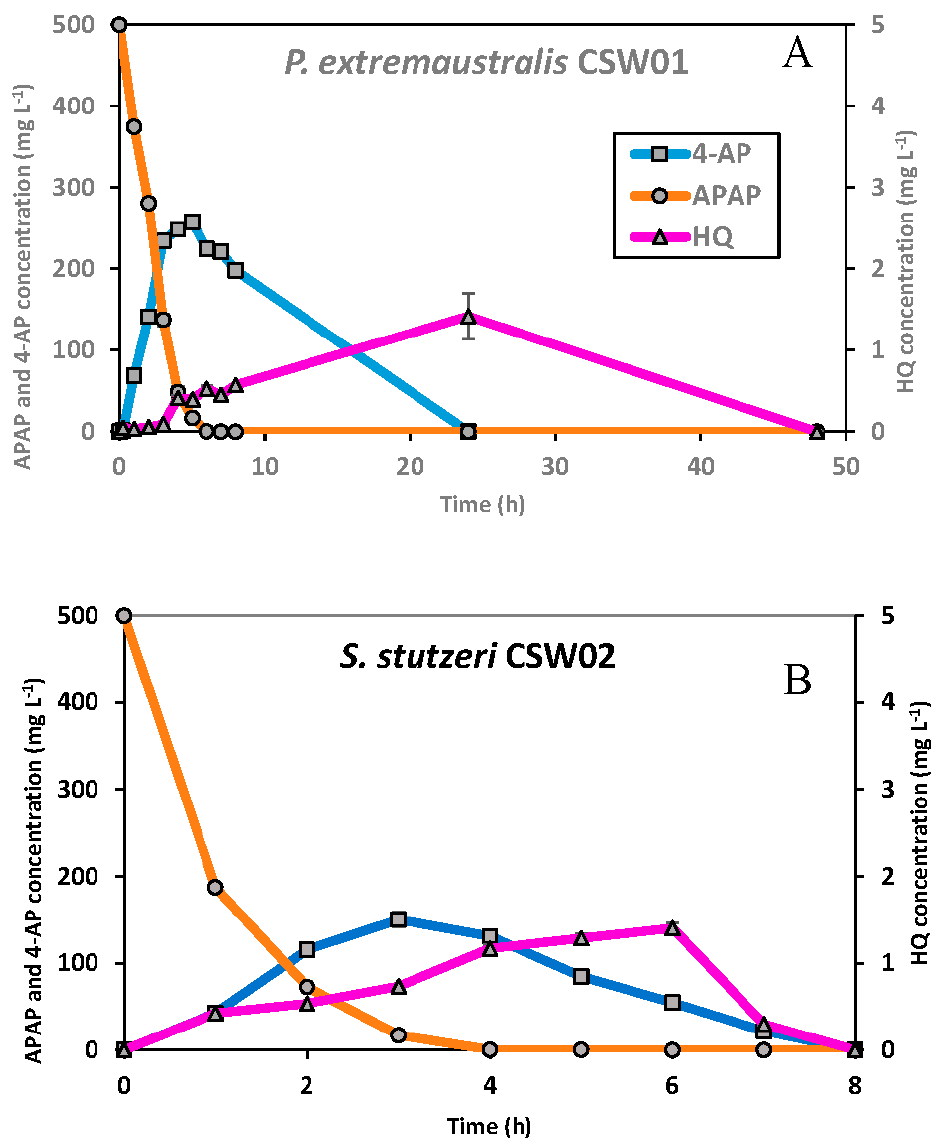
Figure 6. Biodegradation curve for APAP ( ○ ), 4-AP ( □ ), and HQ ( ∆ ) in solution, with an initial APAP concentration of 500 mg L − 1 for P. extremaustralis CSW01 ( A ) and S. stutzeri CSW02 ( B ).